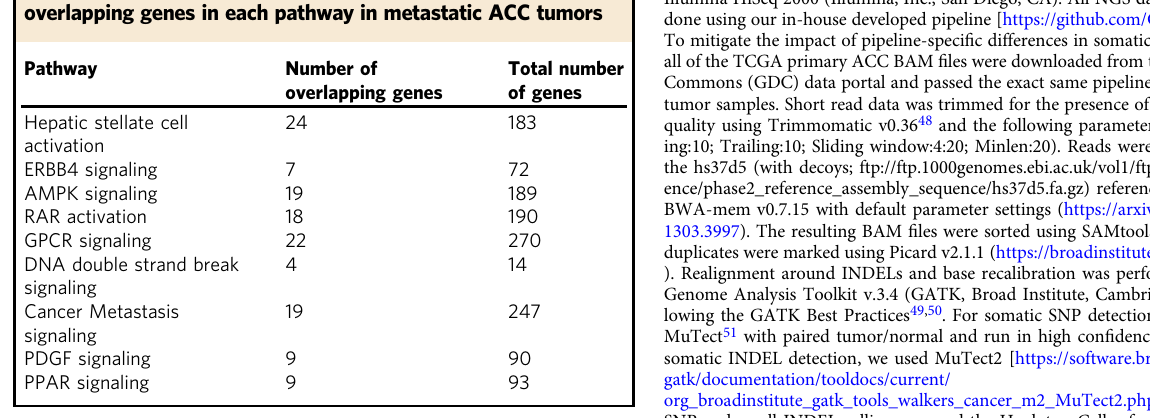
metastatic disease. All diagnosis was con fi rmed by an endocrine pathologist based on the Weiss criteria, and tumor samples were con fi rmed to contain ≥ 90% tumor cells/nuclei. Tumor samples were obtained at surgical resection and immediately snap frozen and stored at − 80 °C.